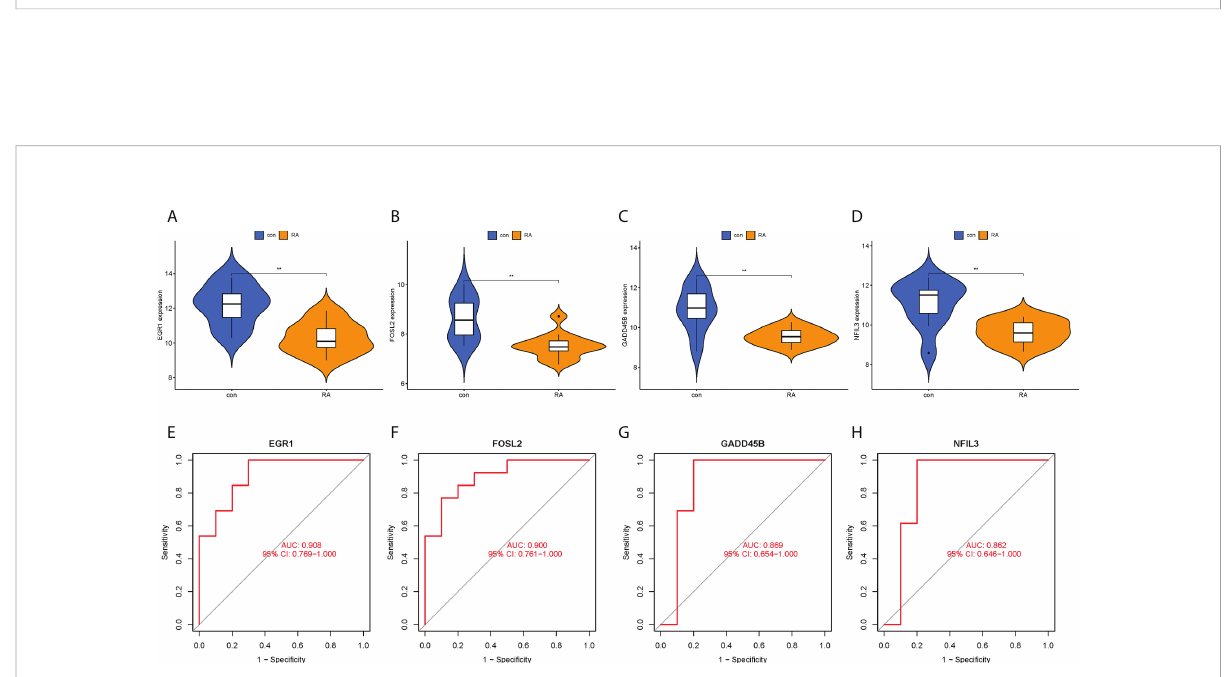
FIGURE 9 Validation of hub CRGs with GSE55457 dataset. (A – D) Violin plots of the differences in expression levels of four hub genes between RA and control groups. (E – H) ROC curves of diagnostic ef fi cacy of each hub gene for RA. **p < 0.01. AUC, area under the curve.